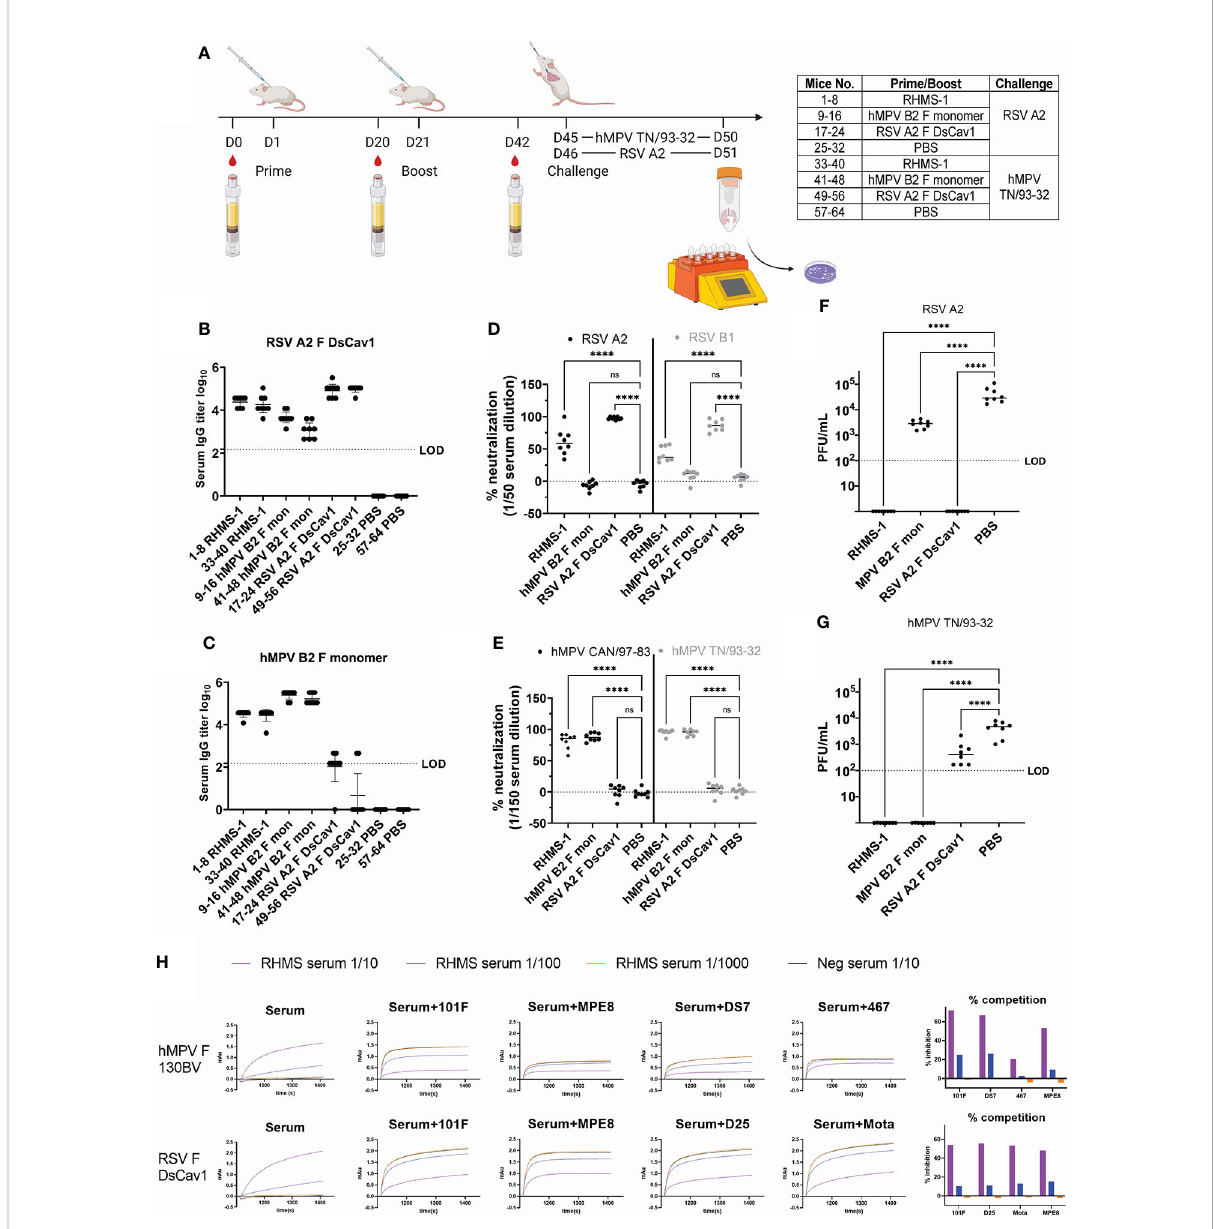
FIGURE 6 Mouse immunization and challenge studies. (A) Study regimen. Day 42 serum IgG titers against RSV A2 F DsCav1 (B) and trypsinized hMPV B2 F monomer (C) before challenge. (D) Serum neutralization against RSV A2 and B1 strains at 1/50 dilution and against (E) hMPV CAN/97-83 and TN/93-32 at a 1/150 dilution. Viral titers for RSV A2 (F) and hMPV TN/93-32 (G) in the lung homogenates of mice 5 days post-challenge. LOD, limit of detection. (H) . Competition binding of RHMS-1 (serial diluted at 1/10, 1/100, and 1/1000) or mock (1/10 diluted) vaccinated Day 42 serum with reference mAbs. ns, not signi fi cant. ****P <